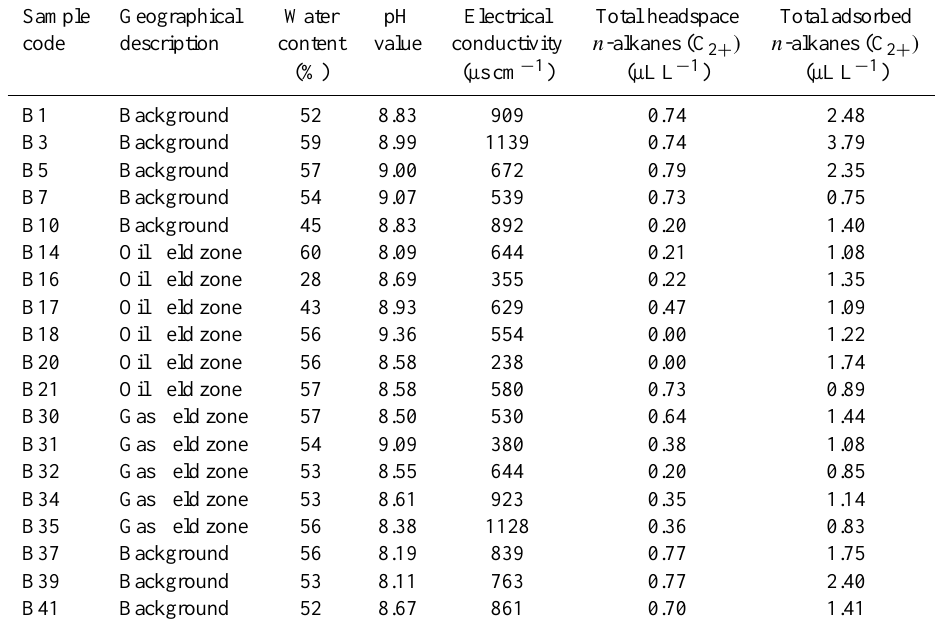
Table 1. General soil properties, headspace and adsorbed n -alkanes content of research area ∗ . Sample Geographical